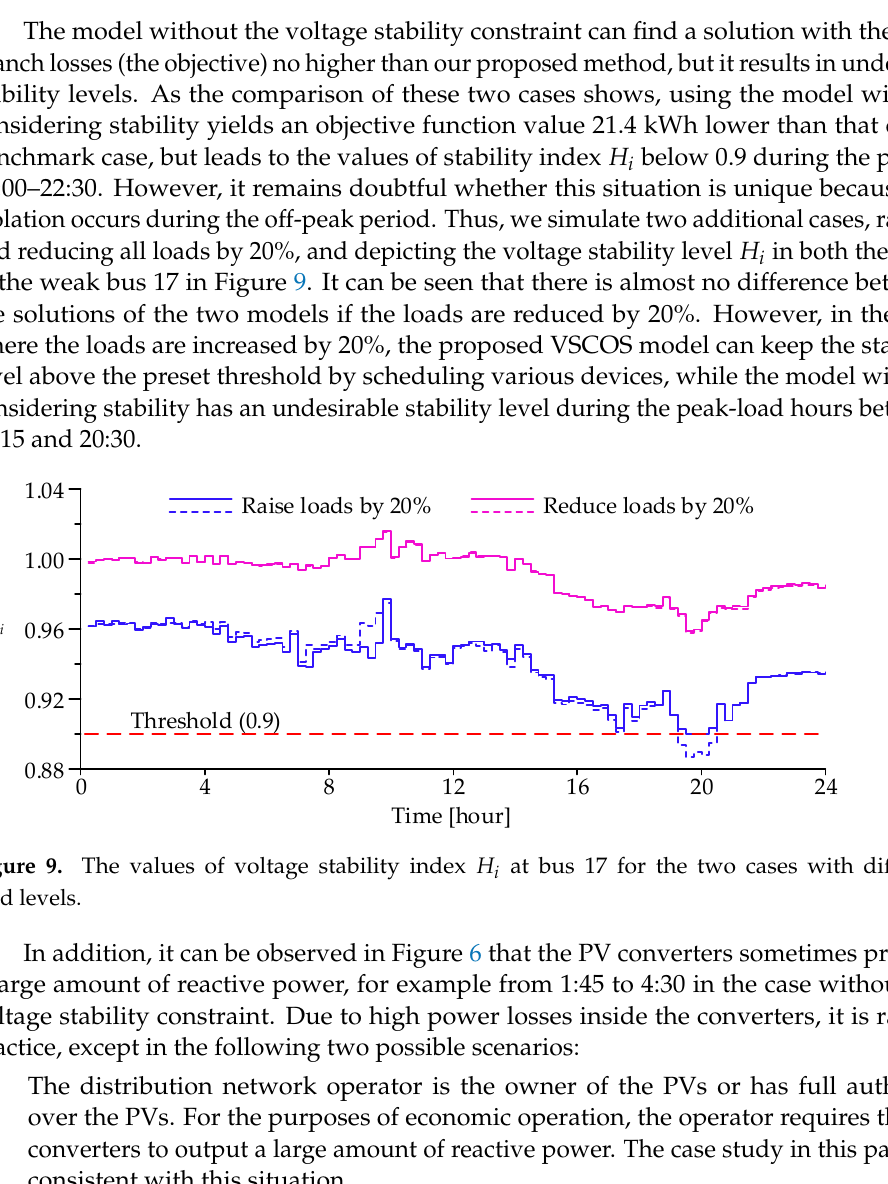
H at bus 17 for the two cases with different load i